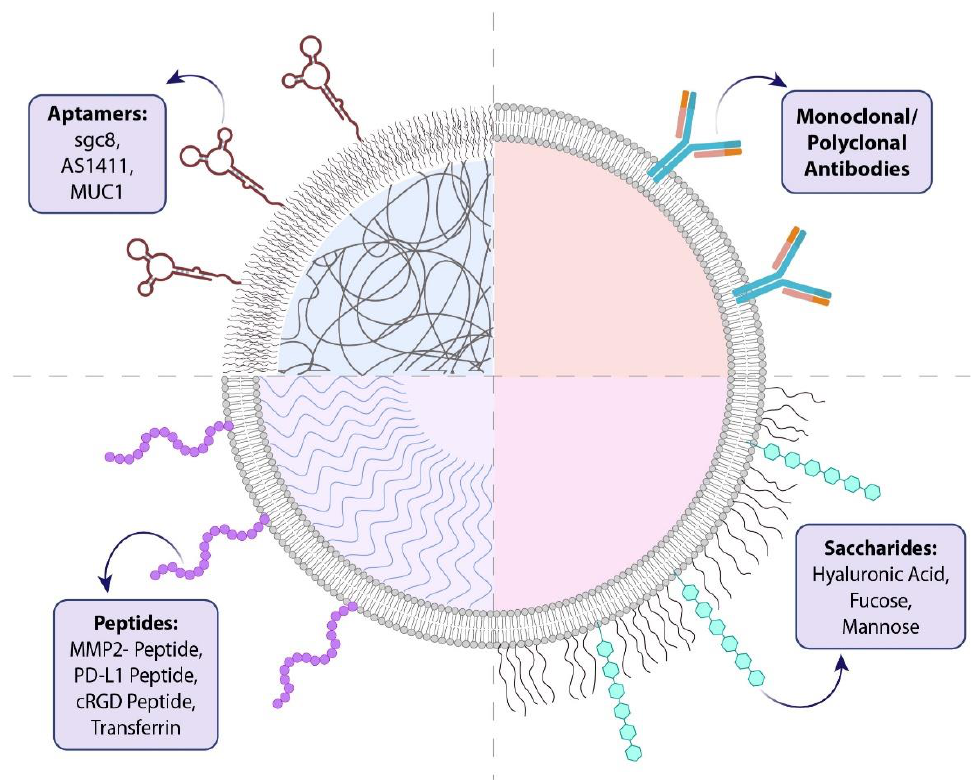
Figure 3. Different molecules that can be utilized for targeting nanoparticles. Different molecules can be employed to generate targeted nanodrug delivery systems for the treatment of lung cancer. These molecules are chosen according to overexpressed receptors or membrane proteins, or even their affinity for the whole tumor cell. Small peptides, saccharides, antibodies, and aptamers are the most common molecules utilized to target nanoparticles. Table 1. Recently developed targeted nanotherapeutics for lung